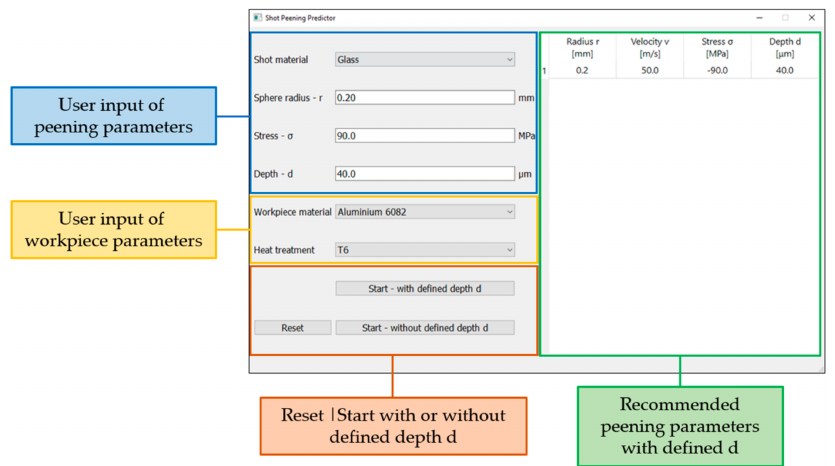
Figure 14. GUI with exemplary values for the prediction of residual stresses (with user-defined stress-corresponding